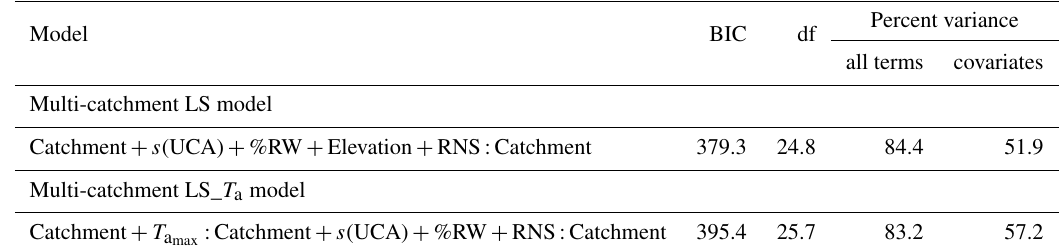
Figure 5. LS model transferability. Panels (a) , (b) , (c) and (d) show predicted T w when the target catchment is the Dee, Tweed, Spey and max Bladnoch, respectively. The colours and symbols indicate the donor catchment: Dee (red circles), Tweed (orange triangles), Spey (dark blue squares) and Bladnoch (light blue diamonds). Filled (open) symbols indicate sites in (out) of the environmental range of the donor catchment. When the target and donor catchments are the same, the coloured points are based on predictions using only covariates; the grey symbols show the corresponding predictions based on the covariates and the RNS. The dashed lines are robust regression lines of observed against predicted values. Models which transfer well have points falling close to the 1 : 1 line. Table 4. Multi-catchment LS and LS_ T a models, with the percent variance explained by the model (all terms) and when the RNS is omitted